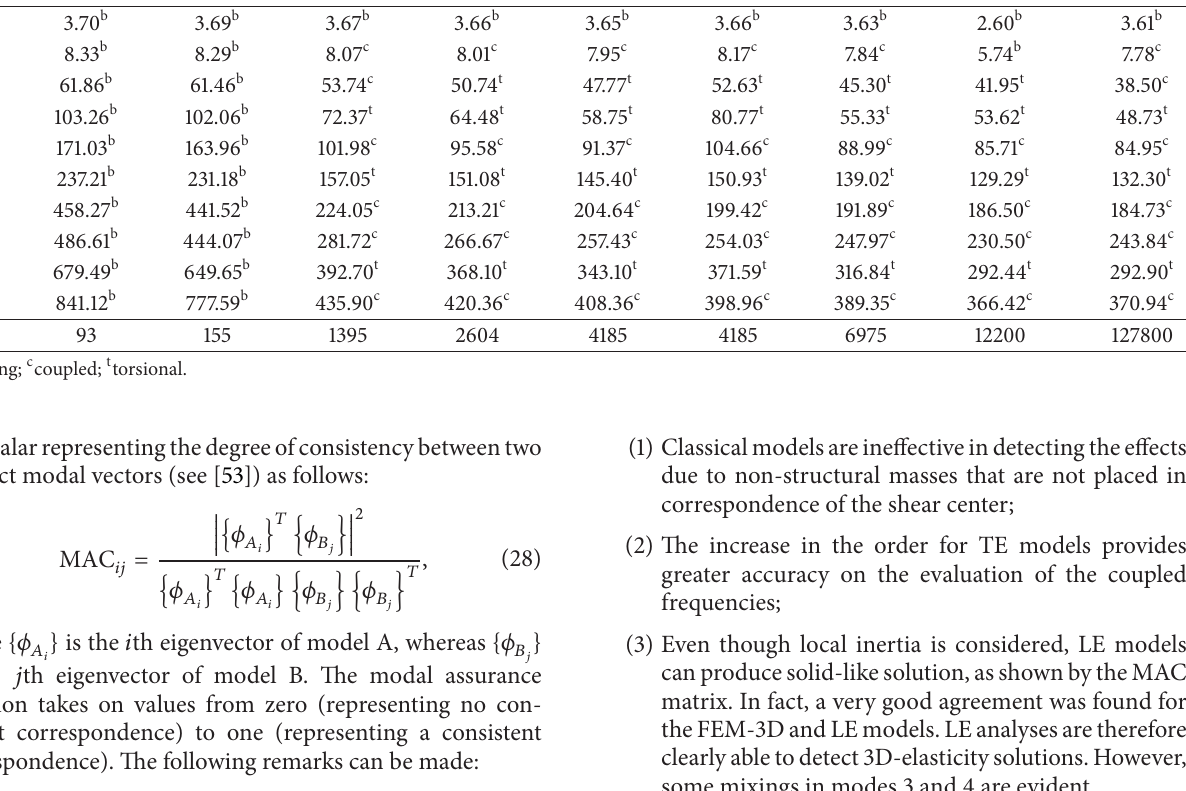
Table 5: First 10 natural frequencies (Hz) for the I-shaped beam with localized inertia at the tip cross-section (Figure 14). Classical and refined models based on TE LE Mode